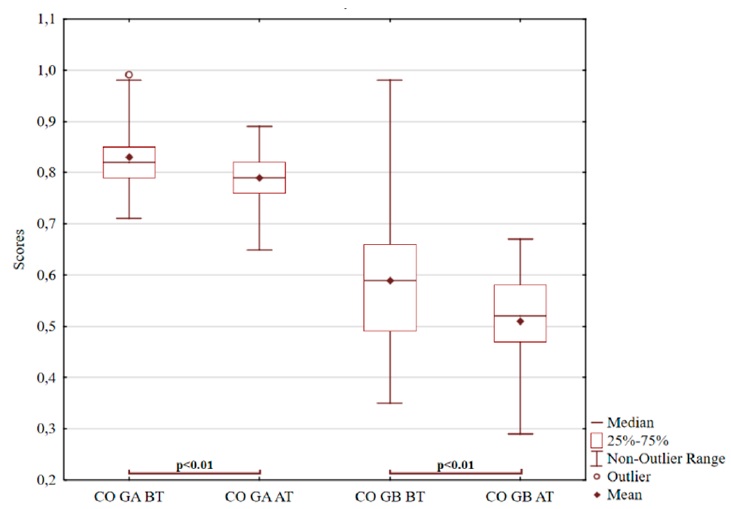
Figure 1. ROR for pure colour answers. Notes for Graph 1–6: BT before treatment; AT after treatment; GA Group A; GB Group B; CO pure colour answers; AN interpretation of animal; BL interpretation of blood; RE contact with reality.